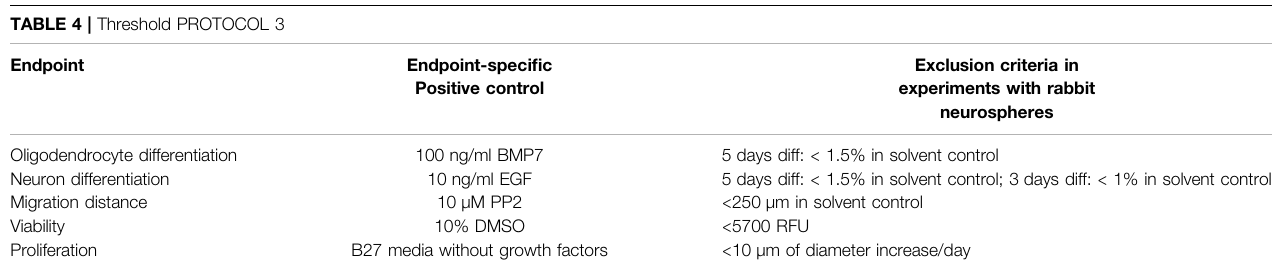
TABLE 4 | Threshold PROTOCOL